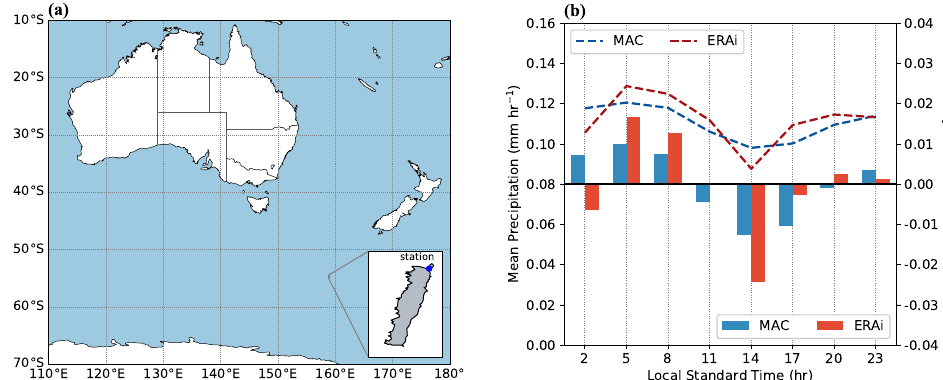
Figure 1. ( a ) Regional map showing the location of Macquarie Island in the Southern Ocean. The inset — shows Macquarie Island (MAC) together with the approximate location of the station at the northern part. ( b ) Mean diurnal cycle of precipitation (left axis, dashed lines) and anomalies (right axis, bars) for both MAC observations and the ERA-Interim dataset, for the total